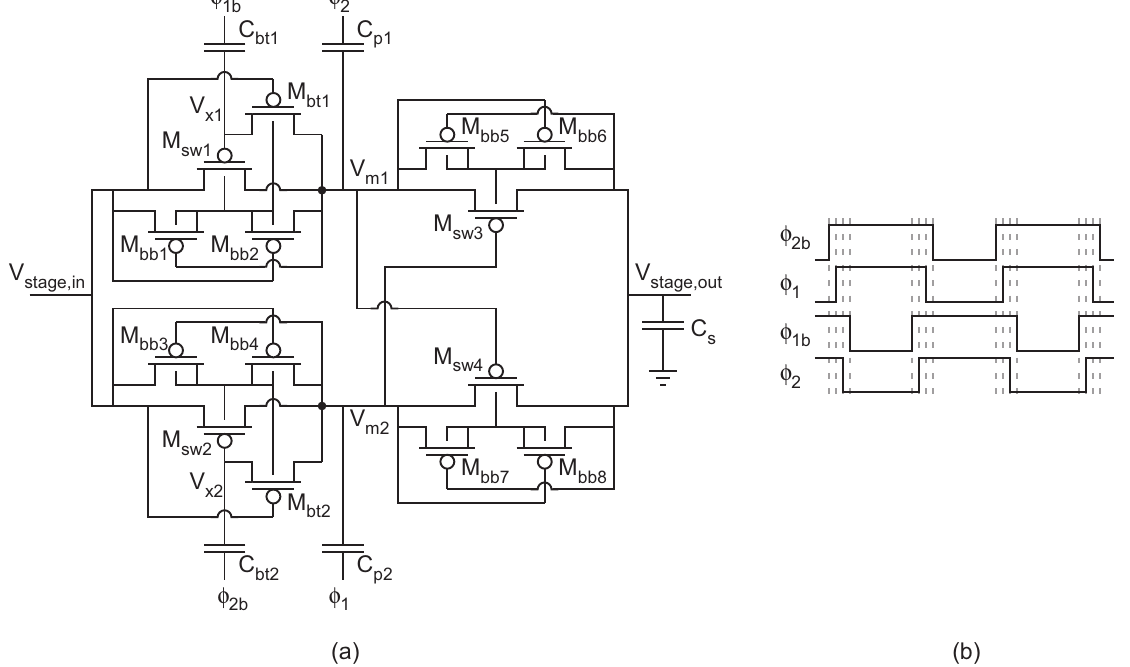
Figure 7. ( a ) The charge transfer switch (CTS). ( b ) Non-overlapping clock signals necessary for the charge-pump